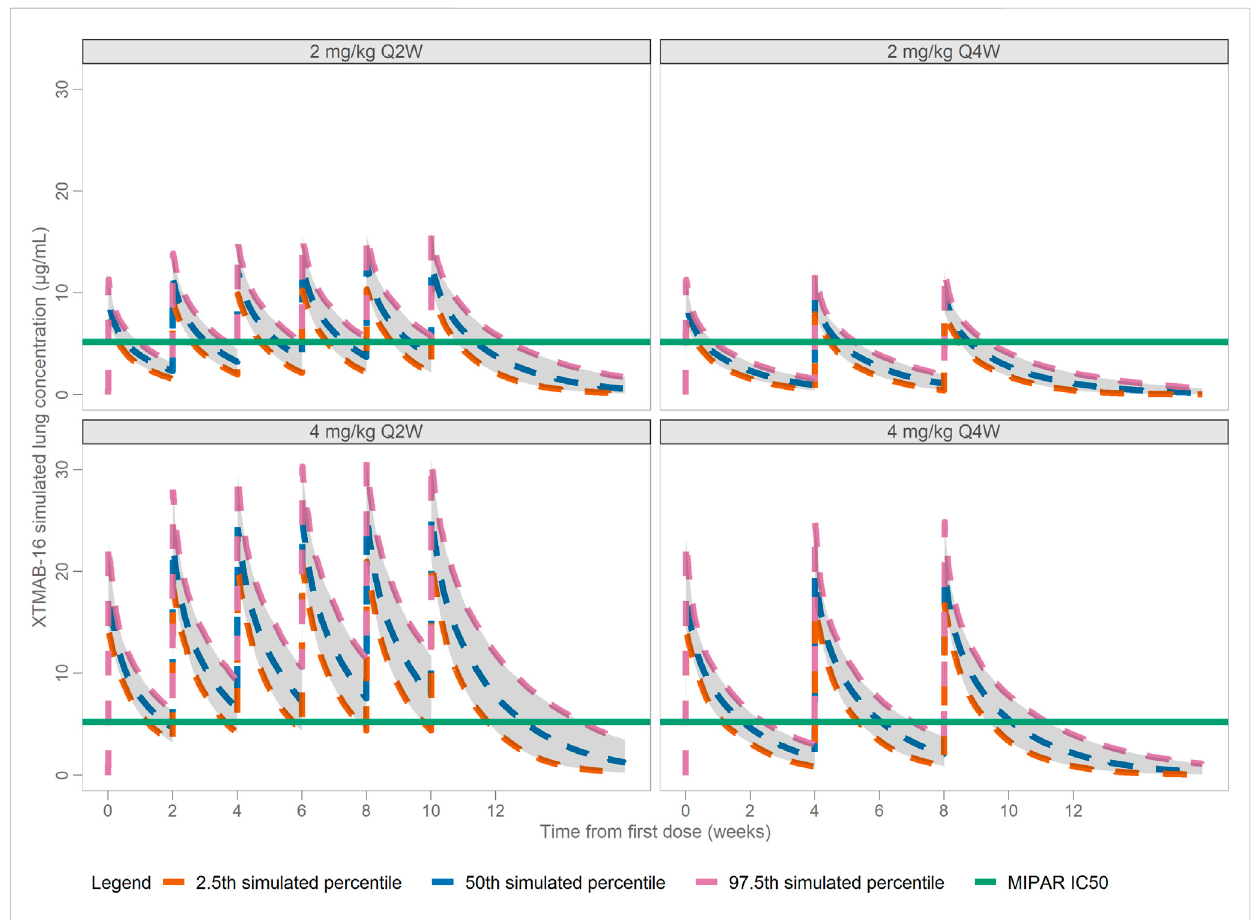
FIGURE 5 Model-Predicted Lung XTMAB-16 Concentration in Virtual Subjects. Abbreviations: IC 50 = concentration at half-maximal MIPAR area fraction de fi ned as the cumulative granuloma area as a percentage of the total area of the image; Q2W = every 2 weeks; Q4W = every 4